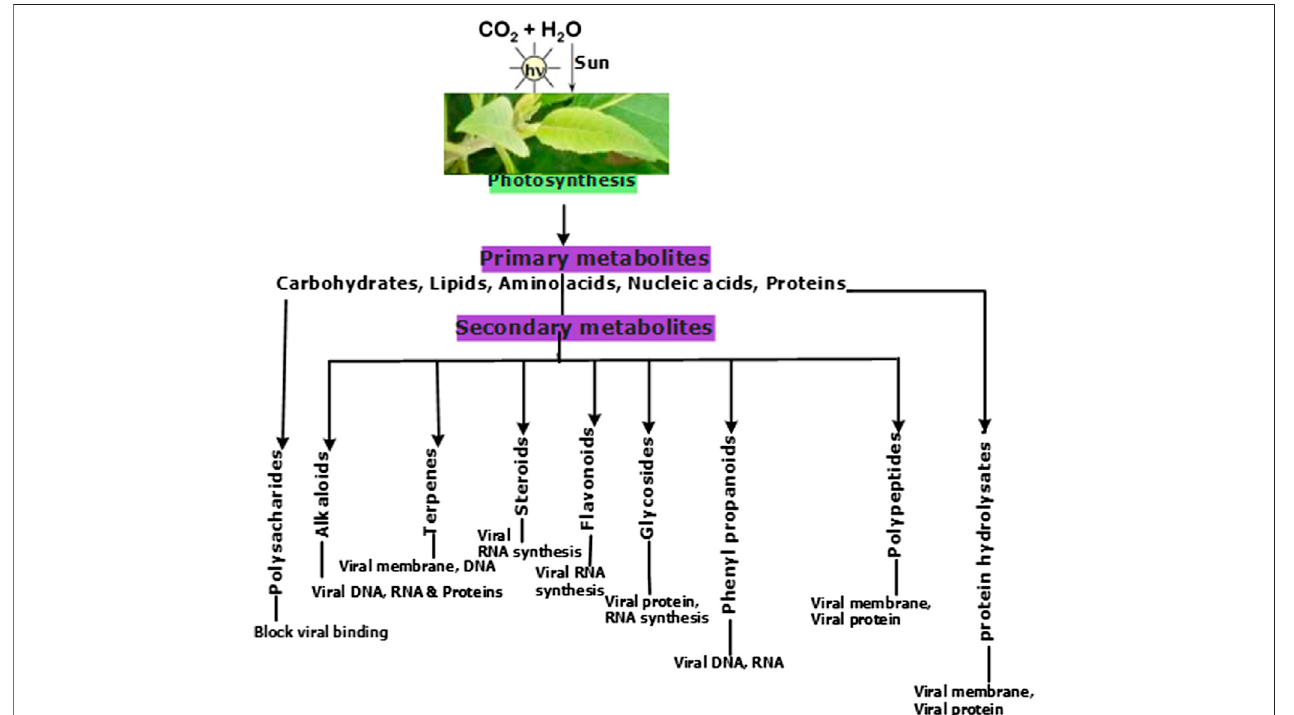
FIGURE 3 | The role of primary and secondary plant metabolites as antiviral